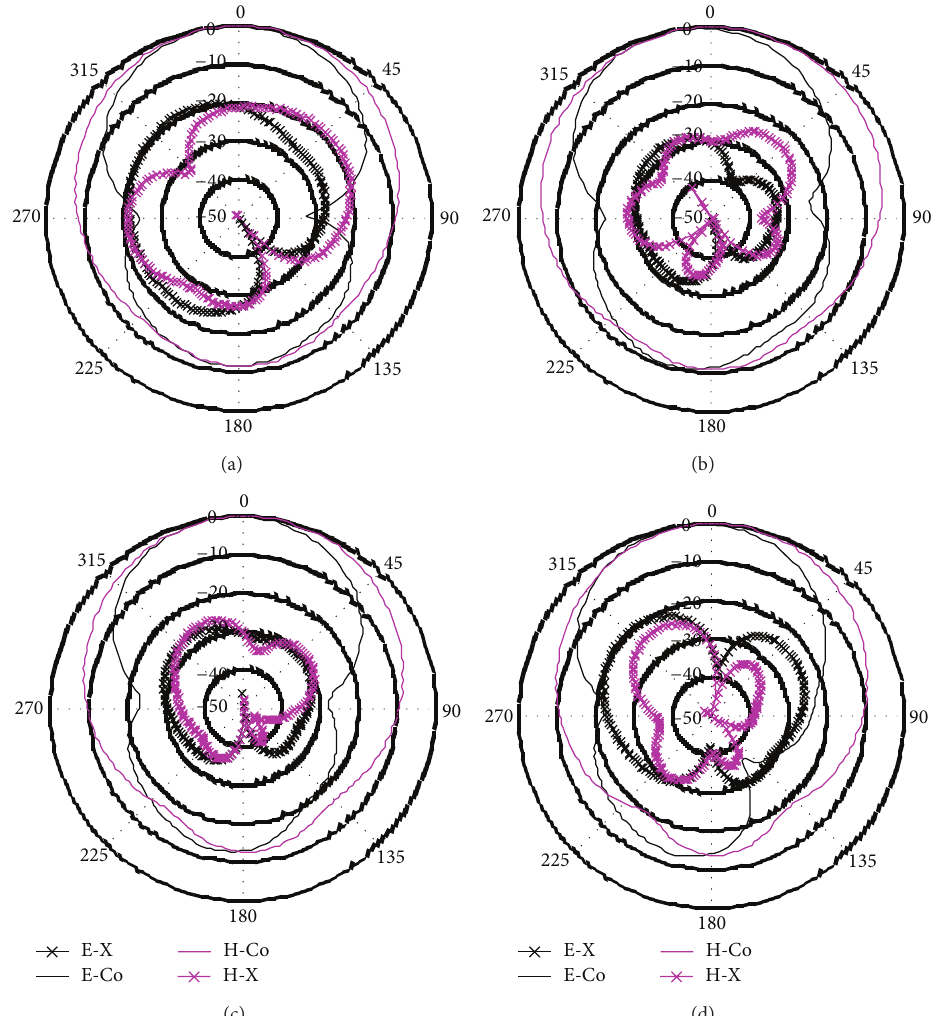
Figure 8: Measured radiation patterns at (a) 4.5, (b) 5.5, (c) 6.0, and (d) 6.7